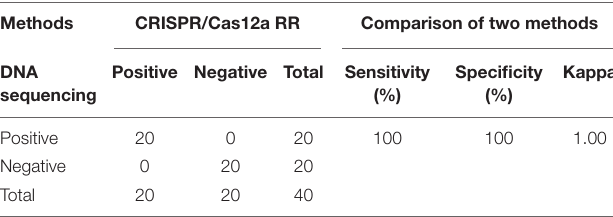
TABLE 2 | Performance comparison between CRISPR/Cas12a RR and DNA sequencing for STR-resistant (K88R) detection in clinical